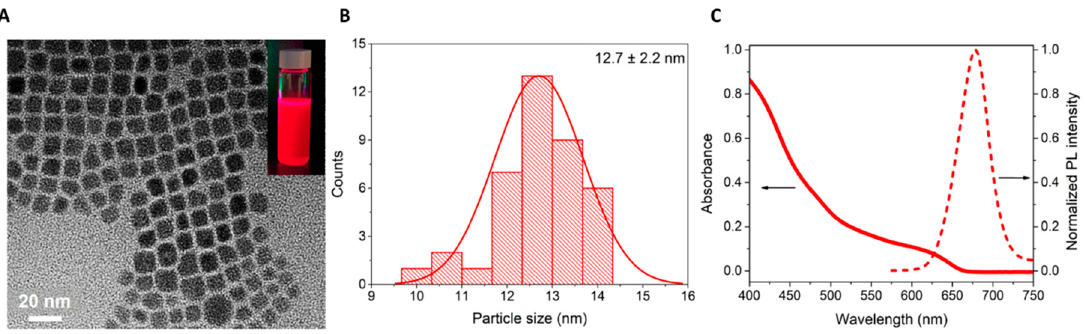
Figure 1. ( A ) TEM image of the CsPbI 3 quantum dots (QDs) synthetized at 170 °C (inset: CsPbI 3 QDs solution in octane), ( B ) CsPbI 3 QDs size distribution histogram, ( C ) absorption and emission spectra of the synthetized CsPbI 3 QDs in solution.